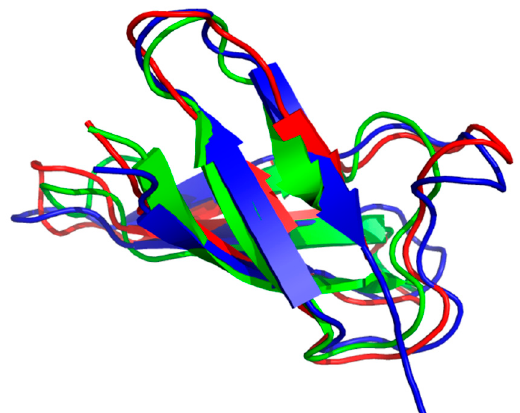
Figure 2. Triple alignment of anti-fungal protein (AFP) (1afp), PAF (2mhv) and Neosartorya fischeri antifungal protein (NFAP) (5oqs) along their CA atoms. (Pymol software tool). Antiparallel β -strands represented by arrows form two overlapping β -sheets. Consecutive strands are connected by short turns or longer loop regions. Green color stands for AFP, red for PAF and blue for NFAP.